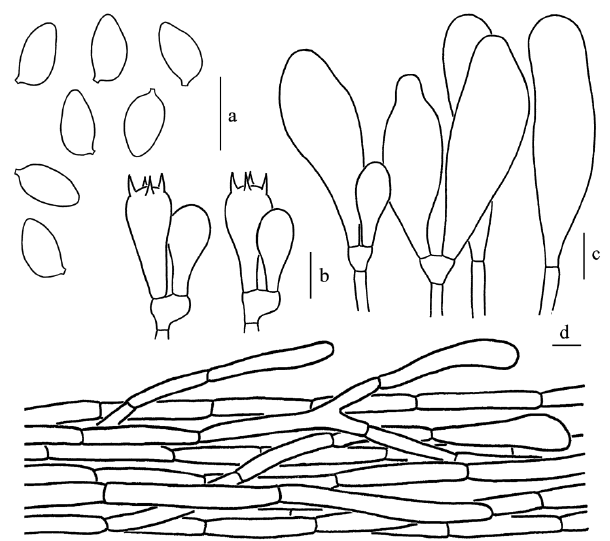
Figure 13. Leucoagaricus virens (CFSZ19869). ( a ) Basidiospores. ( b ) Basidia. ( c ) Cheilocystidia. ( d ) Elements of pileus squamules. Scale bars: 10 μm. Diagnosis: Leucoagaricus virens is characterized by dark green (27E6) to light green (27B3) changes of pileus when bruised or dried; amygdaliform to ellipsoid basidiospores; and narrowly clavate, clavate to fusiform cheilocystidia.